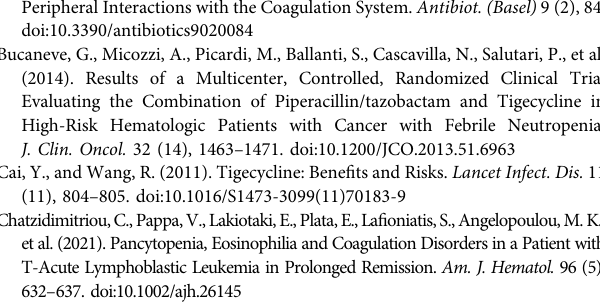
Supplementary Table S3 | Cell adhesion experiments. Supplementary Table S4 | SNP distribution of CHO